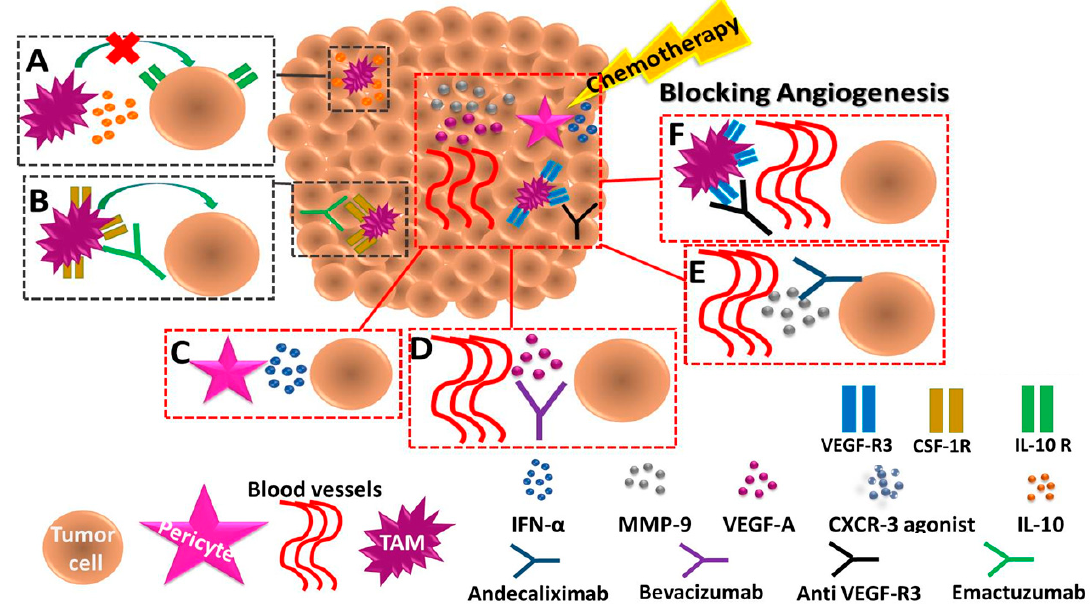
Figure 2. Blunting pro-tumorigenic host responses to chemotherapy by treatment combinations. The illustration provides examples describing ways to block host responses to chemotherapy in order to improve therapeutic outcome. The pro-tumorigenic activity of tumor associated macrophages (TAMs) found following chemotherapy can be targeted based on their function. Specifically, neutralizing IL-10 inhibits the immunosuppressive activity of TAMs, therefore supporting anti-tumor immunity ( A ); and blocking CSF1-R inhibits infiltration of pro-tumorigenic TAMs to the treated TME ( B ). In addition, an induction of angiogenesis following chemotherapy can be blocked by IFN- α which inhibits pericyte function ( C ); by neutralizing VEGF-A ( D ); and by blocking MMP-9 ( E ). Moreover, blocking VEGF-R3 inhibits TAM-induced lymphangiogenesis ( F ). These combined therapies can improve the therapeutic outcome of chemotherapy and inhibit metastasis.